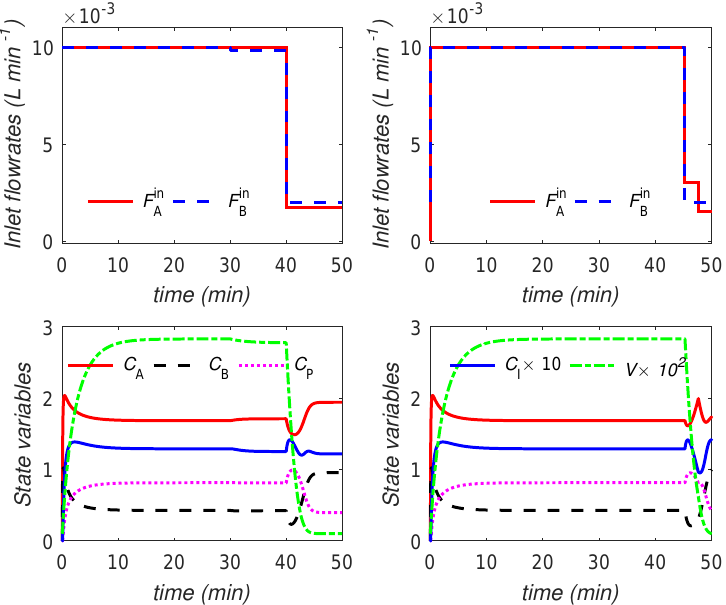
Figure 11. Optimal trajectories for Problem (44) in the case of the uniform ( left ) and proposed ( right ) discretization methods both with N = 5